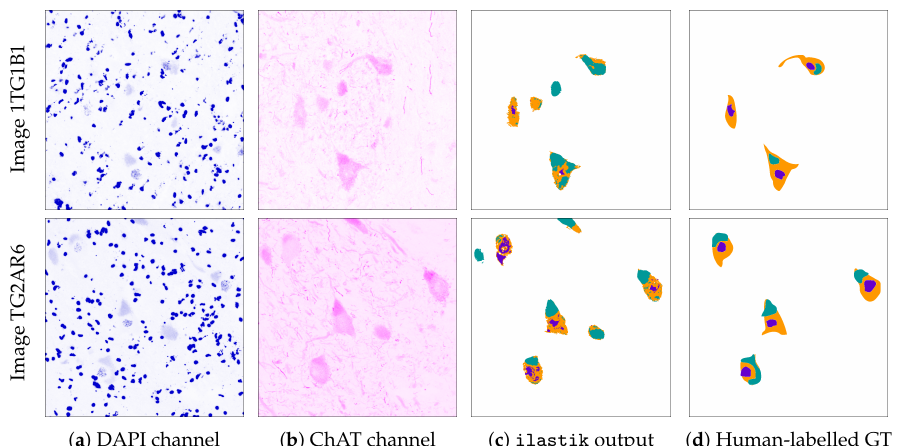
Figure 4. Two examples of MN segmentation and labelling using ilastik . Each example takes up one row. For each example, the columns display ( a , b ) channels DAPI (coloured in blue) and ChAT (coloured in magenta) in the original image, ( c ) the result of the segmentation using ilastik and ( d ) the Ground Truth (GT) generated by an expert for that same image. In Columns ( c , d ), teal pixels represent inclusions, orange ones represent cytoplasms and purple ones represent nuclei.